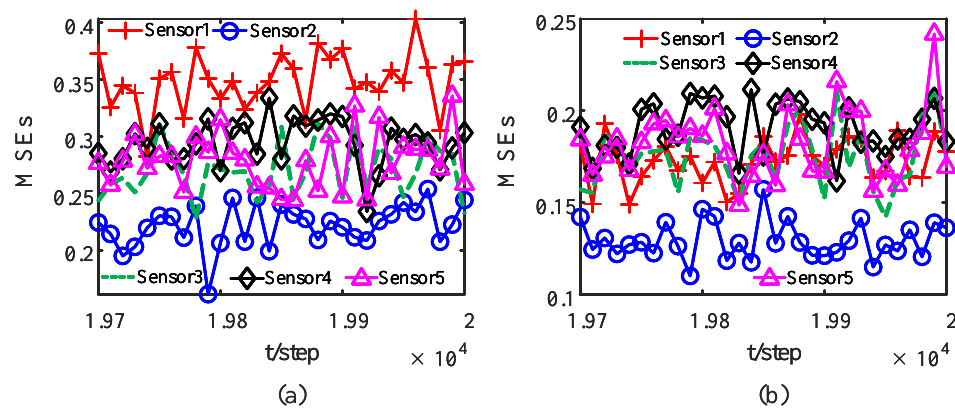
Figure 8. Comparison of MSEs of DSTFCDs of five sensor nodes: ( a ) MSEs of the position filters; ( b ) MSEs of the velocity filters (authors’ own processing).